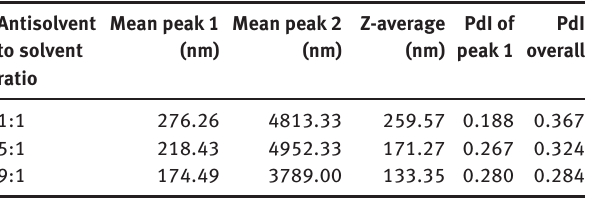
Table 1: Particle sizes and PdI values for different antisolvent to solvent ratios at 12 mL/s and 1200 rpm.